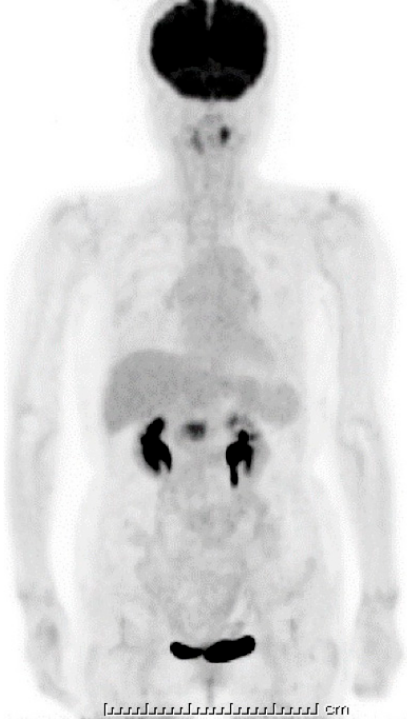
Figure 5. 18 F-fluorodeoxyglucose positron emission tomography (FDG-PET). A strong uptake of FDG was visible at the pancreas head (SUVmax: 6.95); however, this looked smaller when compared with the initial computed tomography (CT) image. The one unit of under bar is indicating 1cm and total bar length is 25 cm.